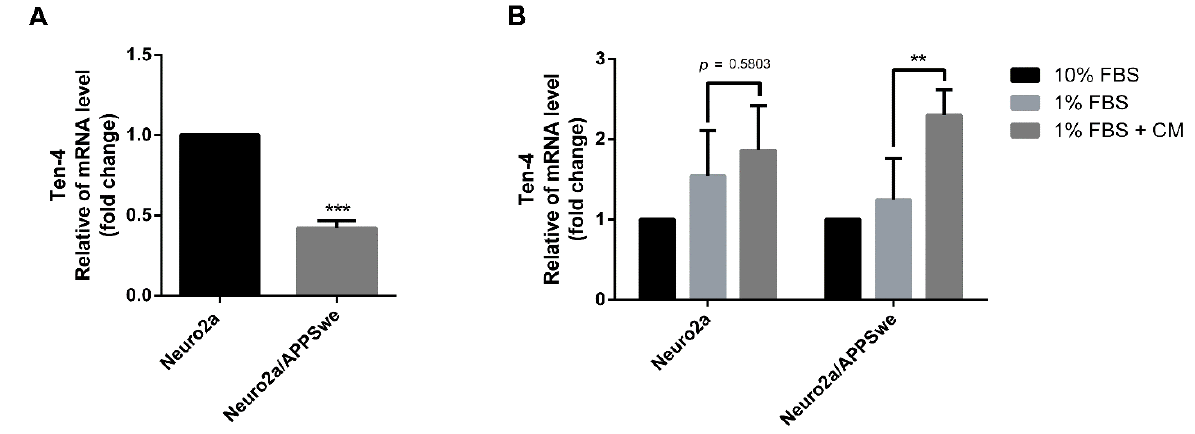
Figure 6. Ten-4 mRNA expression level. ( A ) Neuro2a/APPSwe cells showed significant lower Ten-4 gene expression than Neuro2a cells in 1% FBS medium after 48 h treatment. ( B ) The relative Ten-4 mRNA levels between treatment groups of Neuro2a and Neuro2a/APPSwe cell groups were normalized by 10% FBS group from each cell type. Ten-4 gene expression significantly increased in both Neuro2a and Neuro2a/APPSwe cells when treated with 10 µg/mL of CM extract for 48 h compared to 1% FBS treatment in each cell. Values are mean ± SD of at least three independent experiments. ** p- value < 0.01, *** p- value < 0.001.